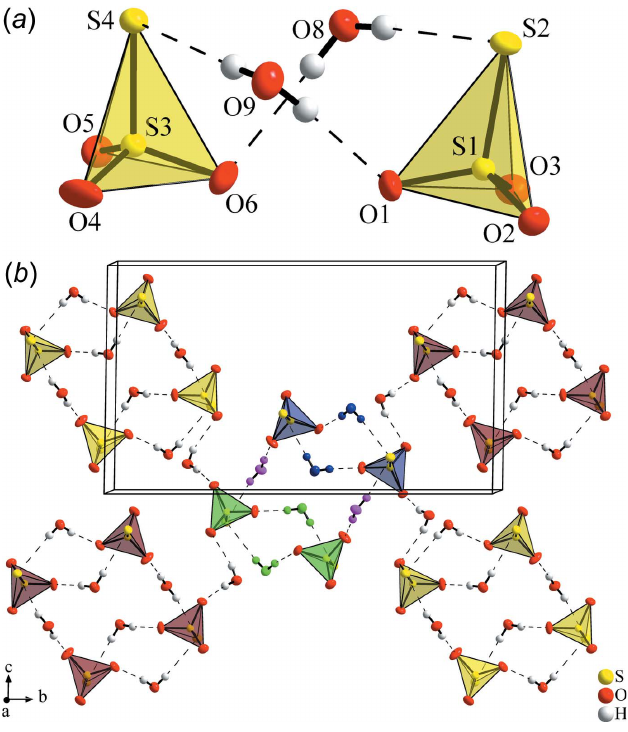
Figure 5 ( a ) A pair of S 2 O 32– anions in Na 2 S 2 O 3 (cid:2) 2H 2 O connected by two H 2 O molecules via hydrogen bonds. ( b ) Illustration of the hydrogen-bond network between thiosulfate anions, drawn as tetrahedra, and water molecules in Na 2 S 2 O 3 (cid:2) 2H 2 O: two S 2 O 3 tetrahedra ( e.g. , the blue ones) are bonded by two H 2 O (blue) to form dimers, which are connected by two H 2 O (pink) with another dimer (green). These tetrameric units are interconnected by H 2 O with neighbouring tetramers (yellow and red